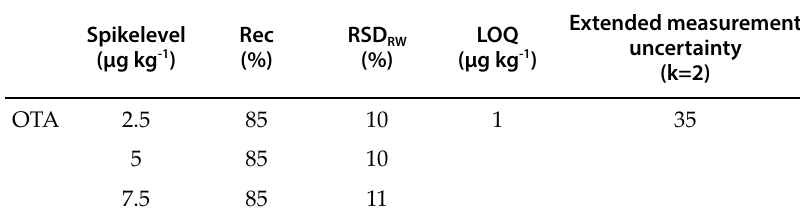
Table 2. Validation of the method of LC MS MS.